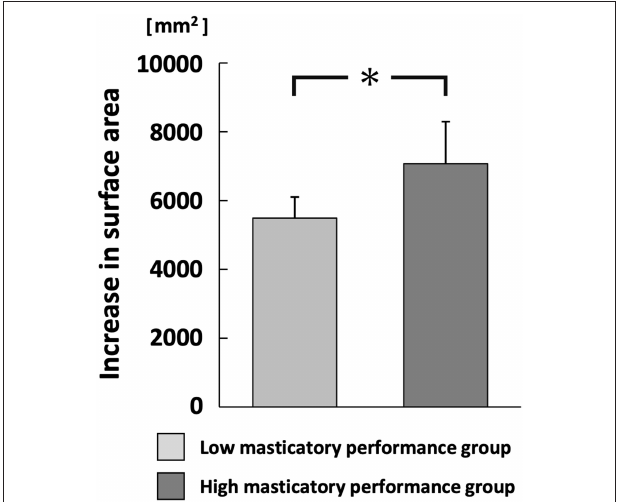
FIGURE 6 | Increase in the surface area of comminuted gummy jelly at chewing strokes equal to 100% of swallowing threshold. * p < 0.05.